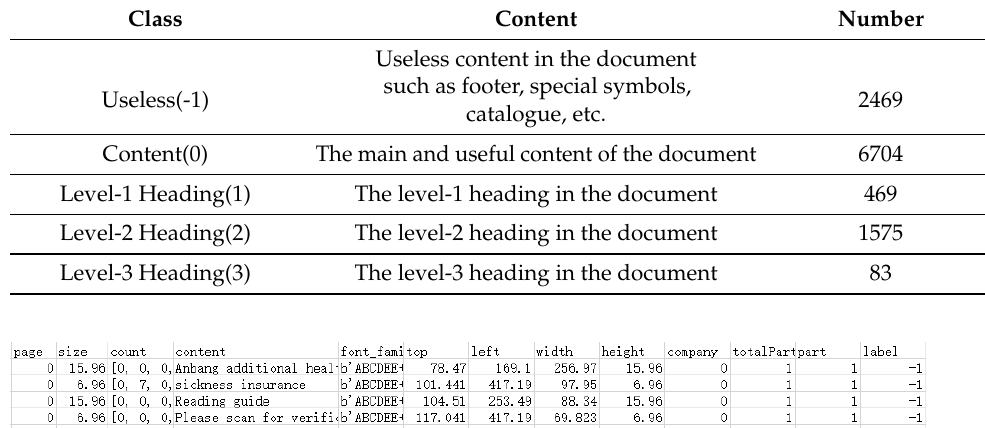
Table 1. Details of the data set. The data set includes five categories and has 11,300 samples.